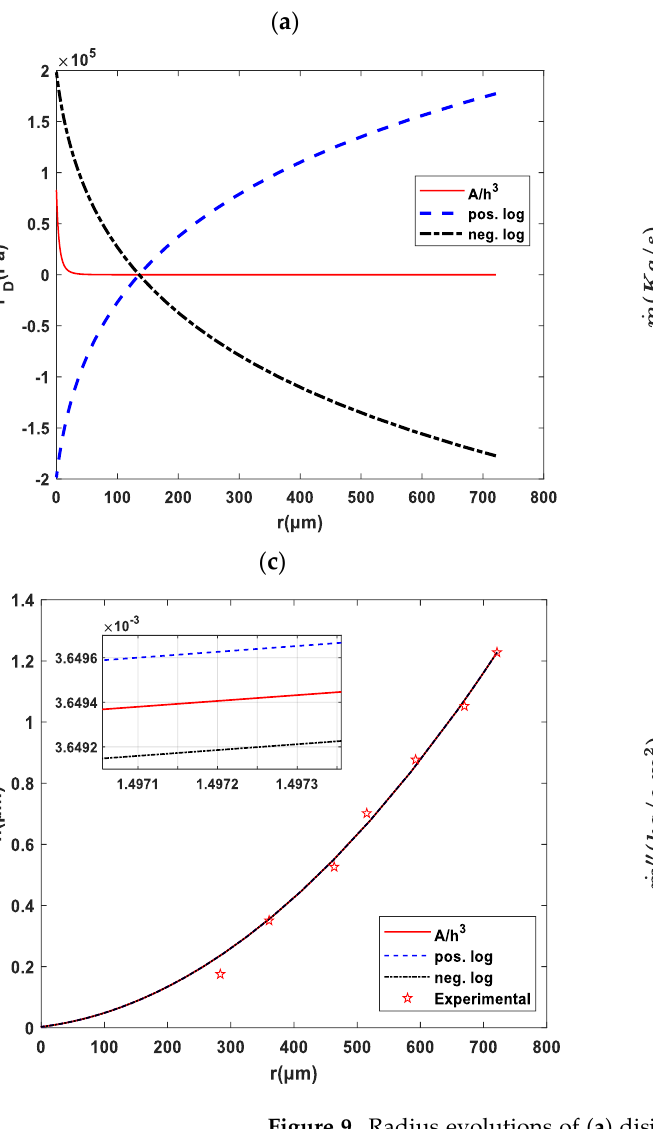
Figure 9. Radius evolutions of ( a ) disjoining pressure; ( b ) mass flow rate; ( c ) film thickness; and ( d ) evaporative mass flux for different disjoining pressure models at a time step of 3.9 ms.